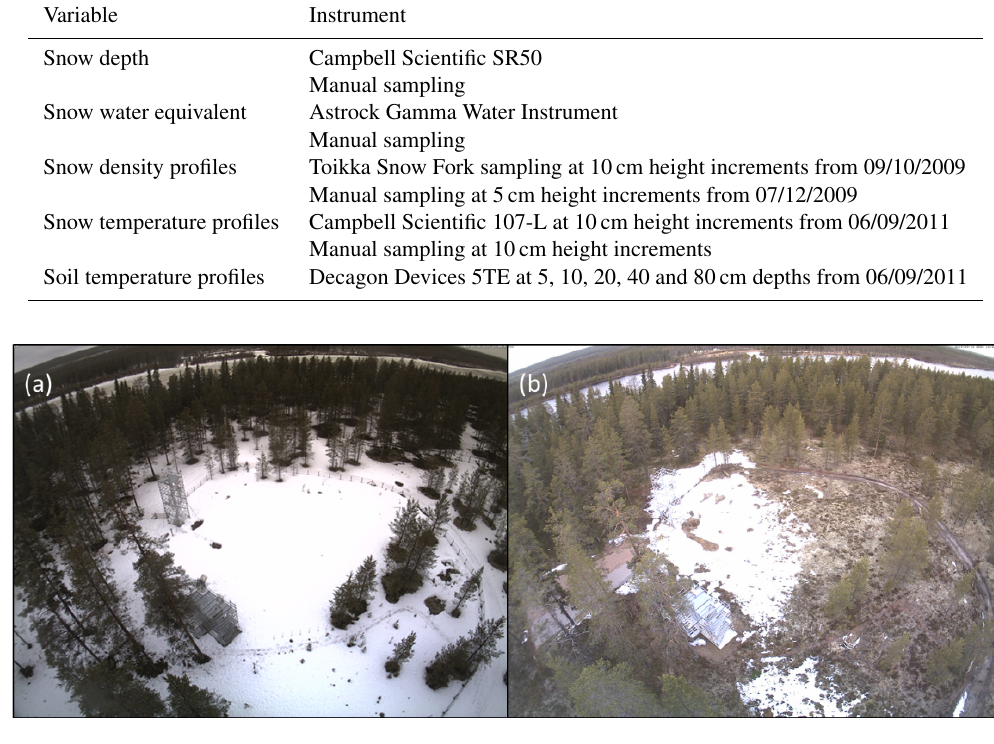
Figure 7. Snow melting in the IOA at noon on (a) 1 May and (b) 13 May